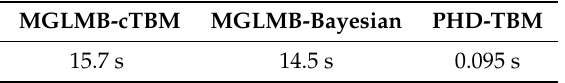
Table 2. Average computational